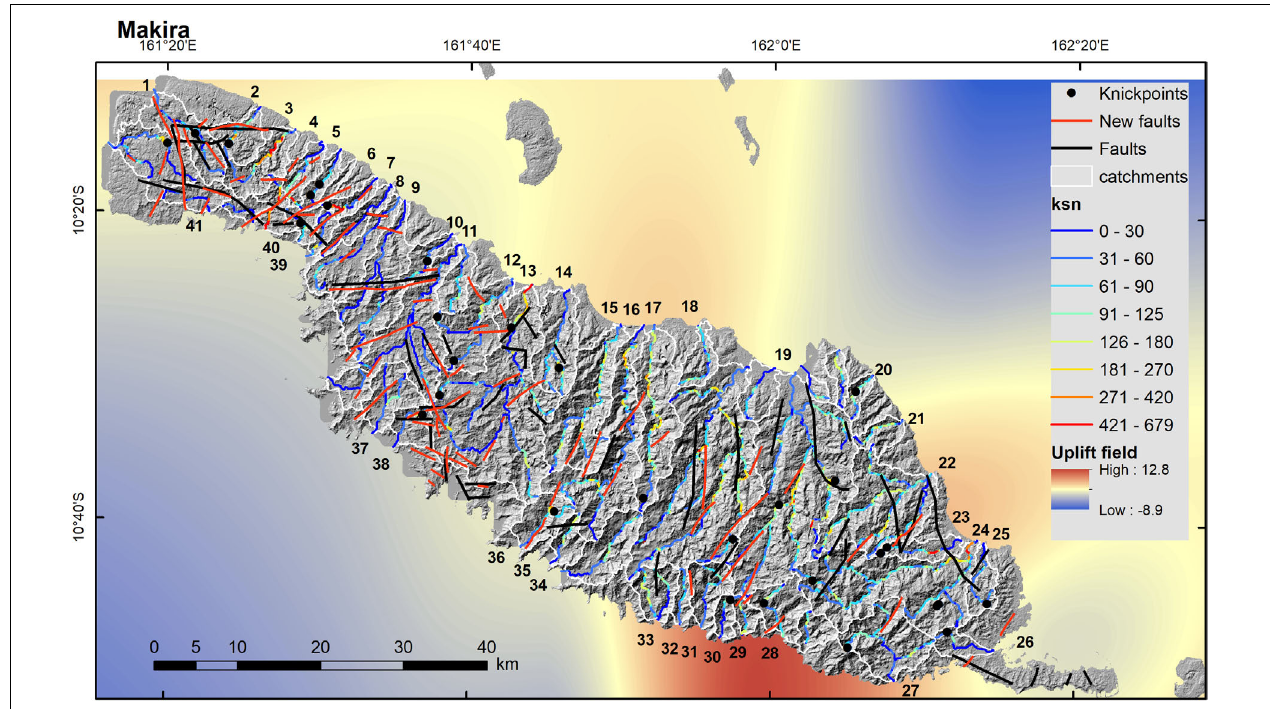
FIGURE 10 | Hillshade map derived from the 30 m SRTM DEM (USGS, 2019) for the island of Makira showing the rivers extracted for analysis shaded by k sn , identified slope-break knickpoints (black circles) and major faults identified from analysis of the DEM and based upon existing mapping data (Department of Geological Surveys,